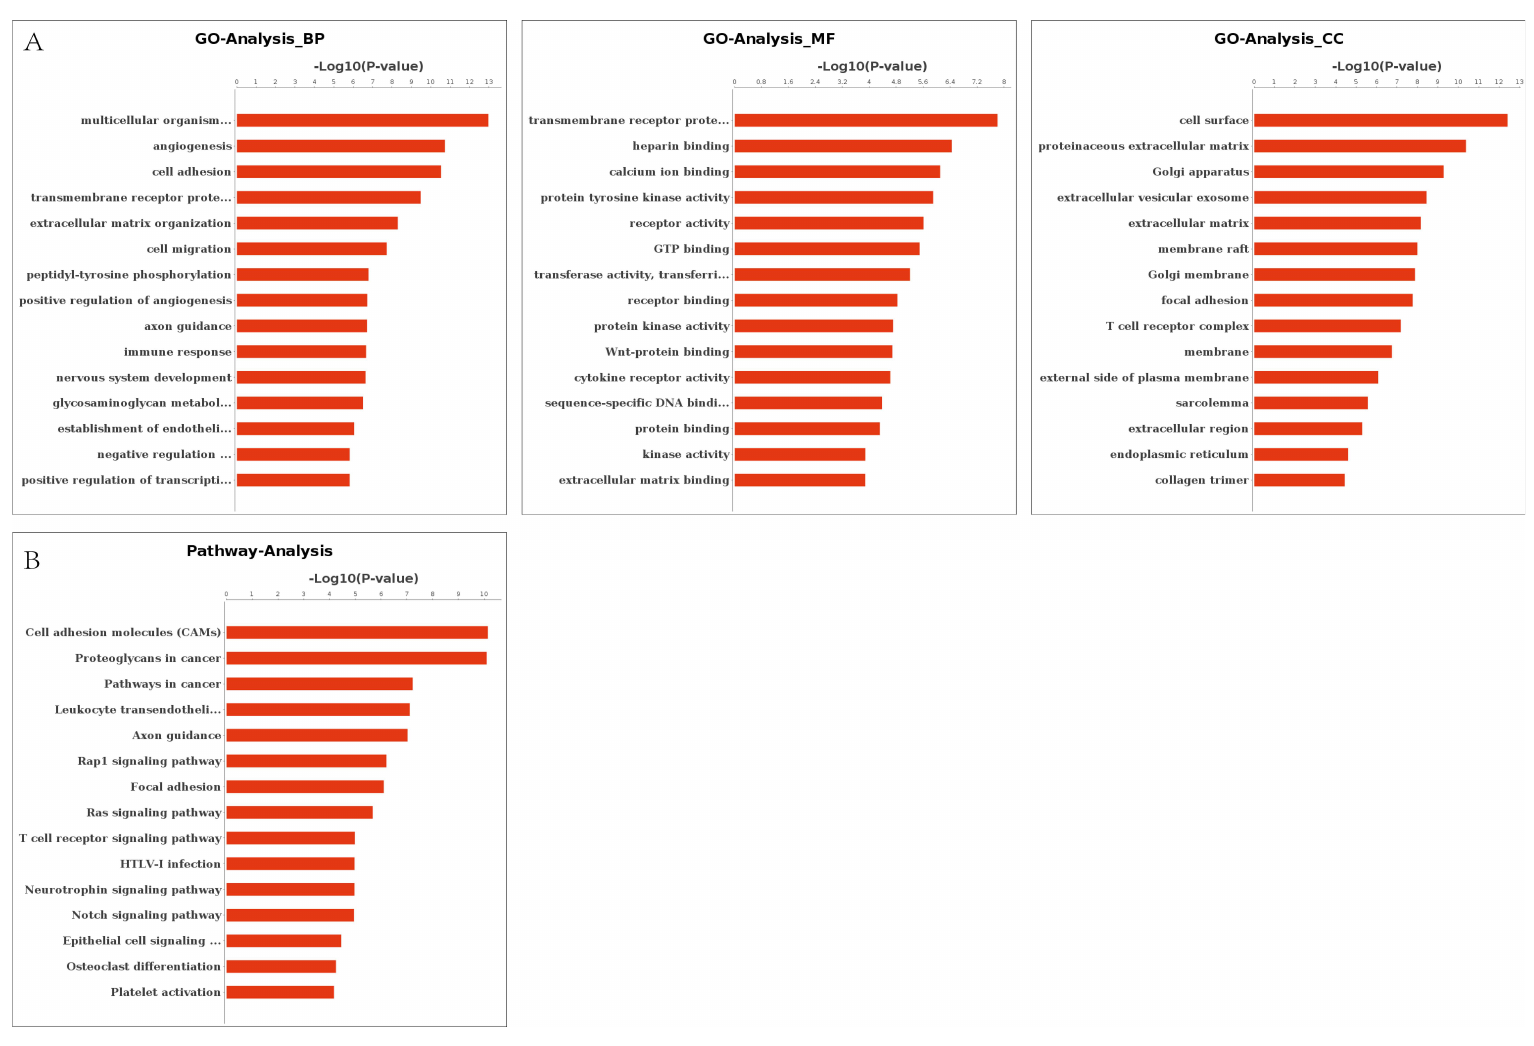
Figure 5. Significantly enriched GO terms and KEGG pathways. ( A ) Significantly enriched GO terms of target genes of differentially expressed miRNA; ( B ) Significantly enriched KEGG pathways of target genes of differentially expressed